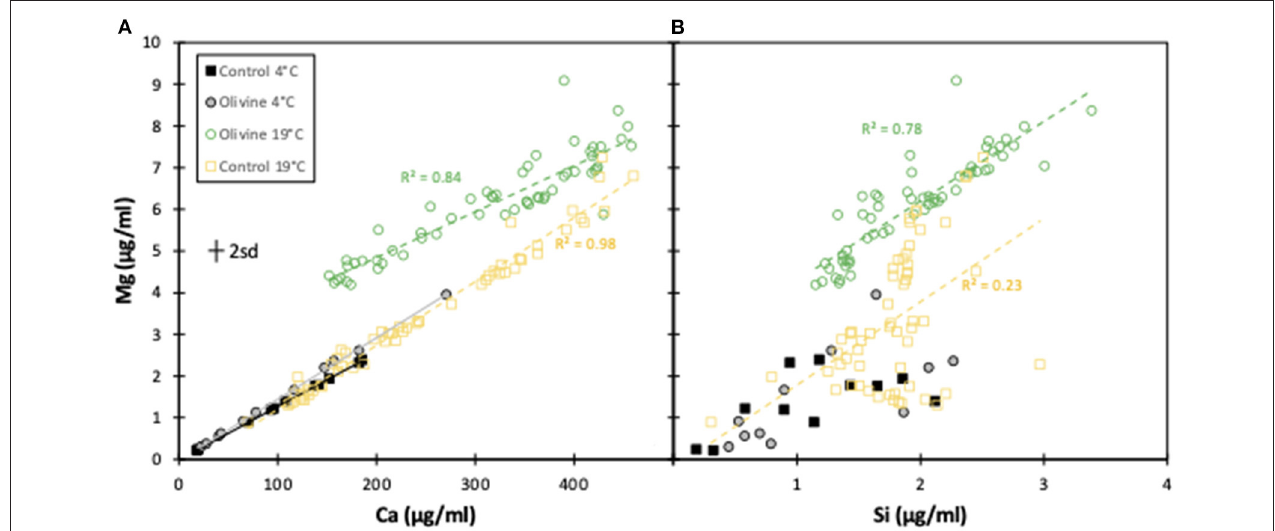
FIGURE 4 | Mg concentrations plotted against Ca and Si concentrations for the effluents from this experiment and the 19 ◦ C experiment (Renforth et al., 2015). In all cases, only the effluent from the 19 ◦ C olivine column shows dissolution of olivine, and not the 4 ◦ C olivine column. The error bar represents the 2sd analytical uncertainty.